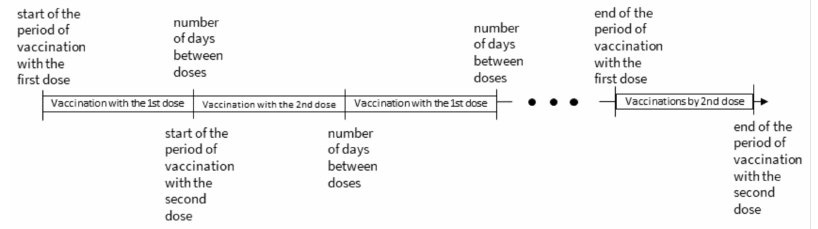
Figure 6. Assumed vaccination scheme with two-dose